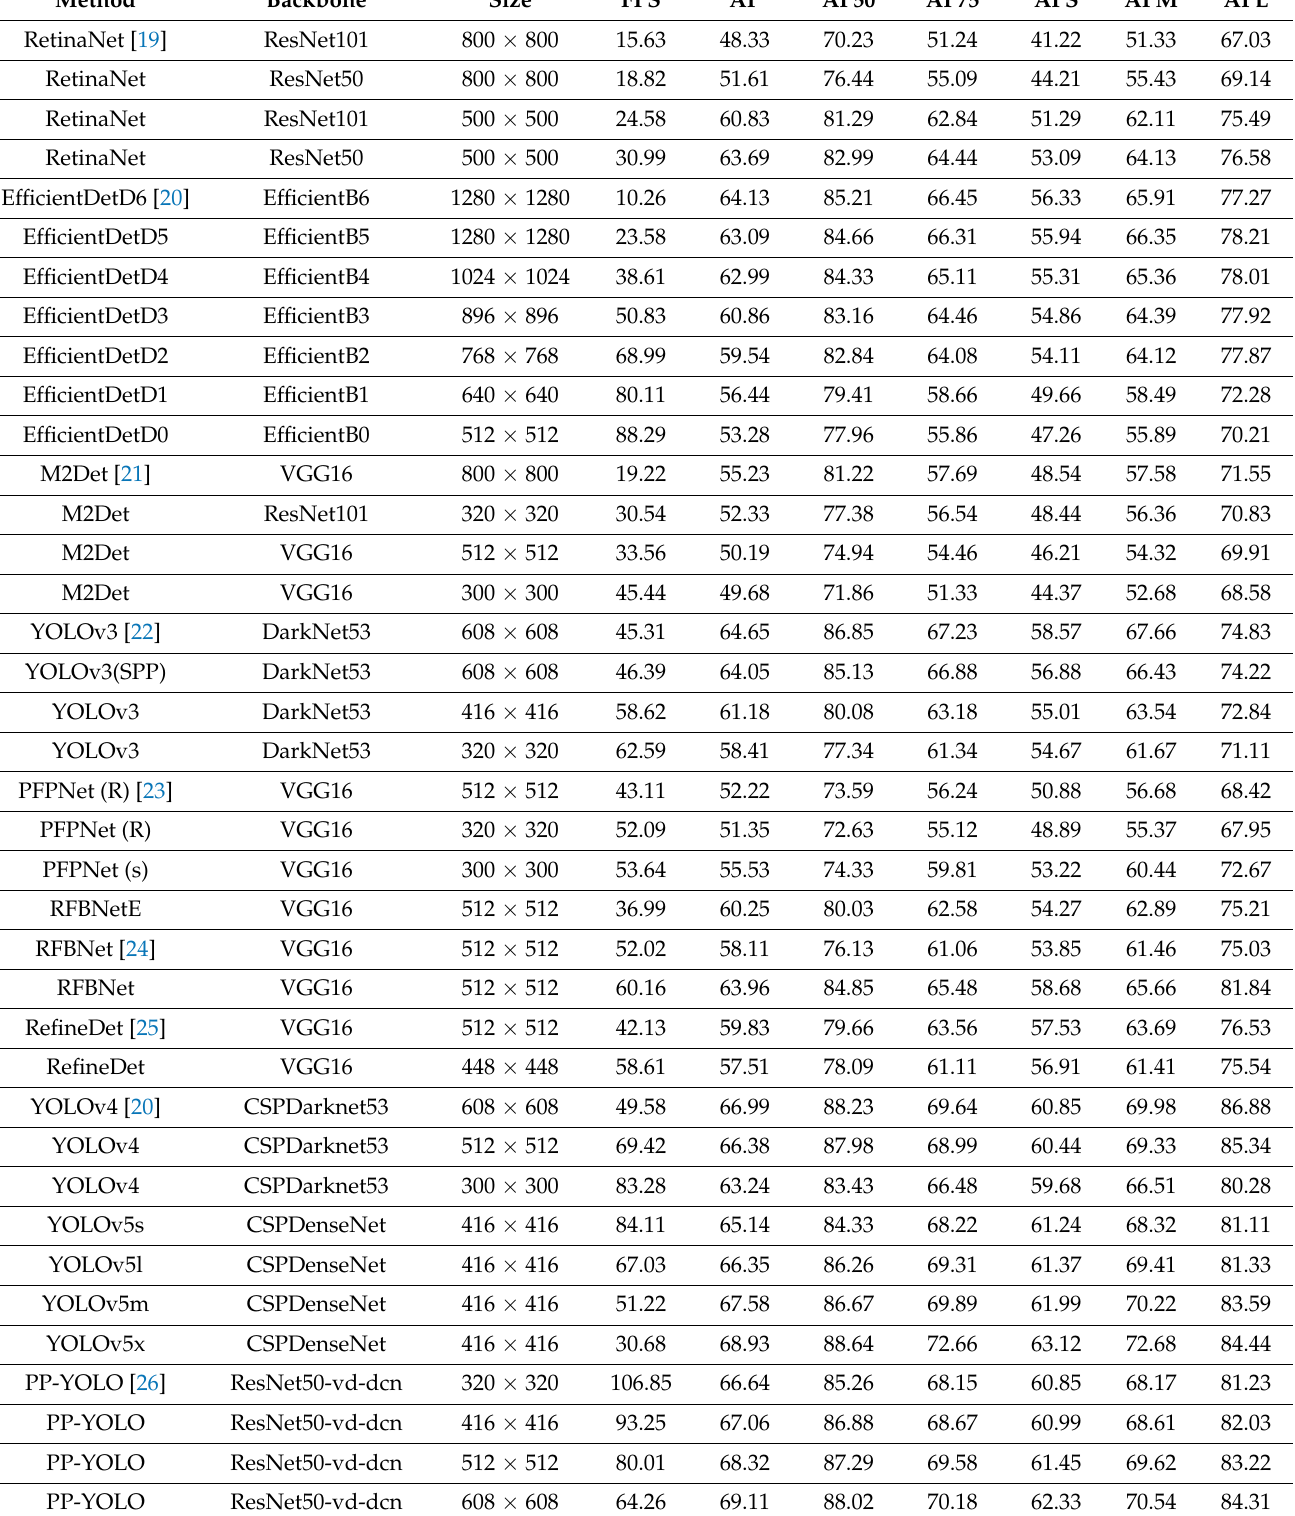
Table 4. Comparisons with state-of-the-art detection